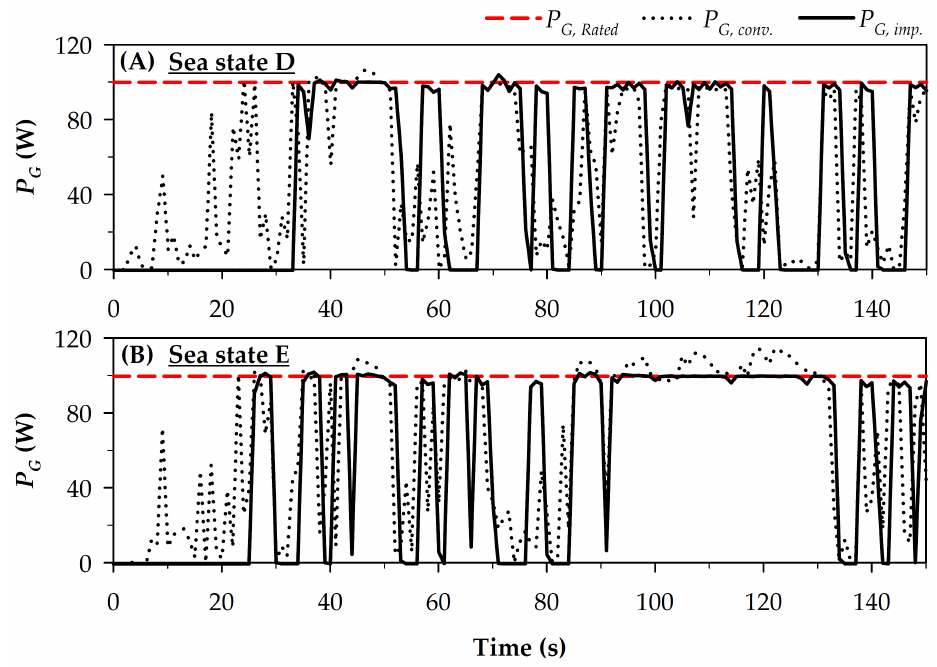
Figure 18. Comparison of the P G , conv . and P G , imp . profiles for the different wave peak period